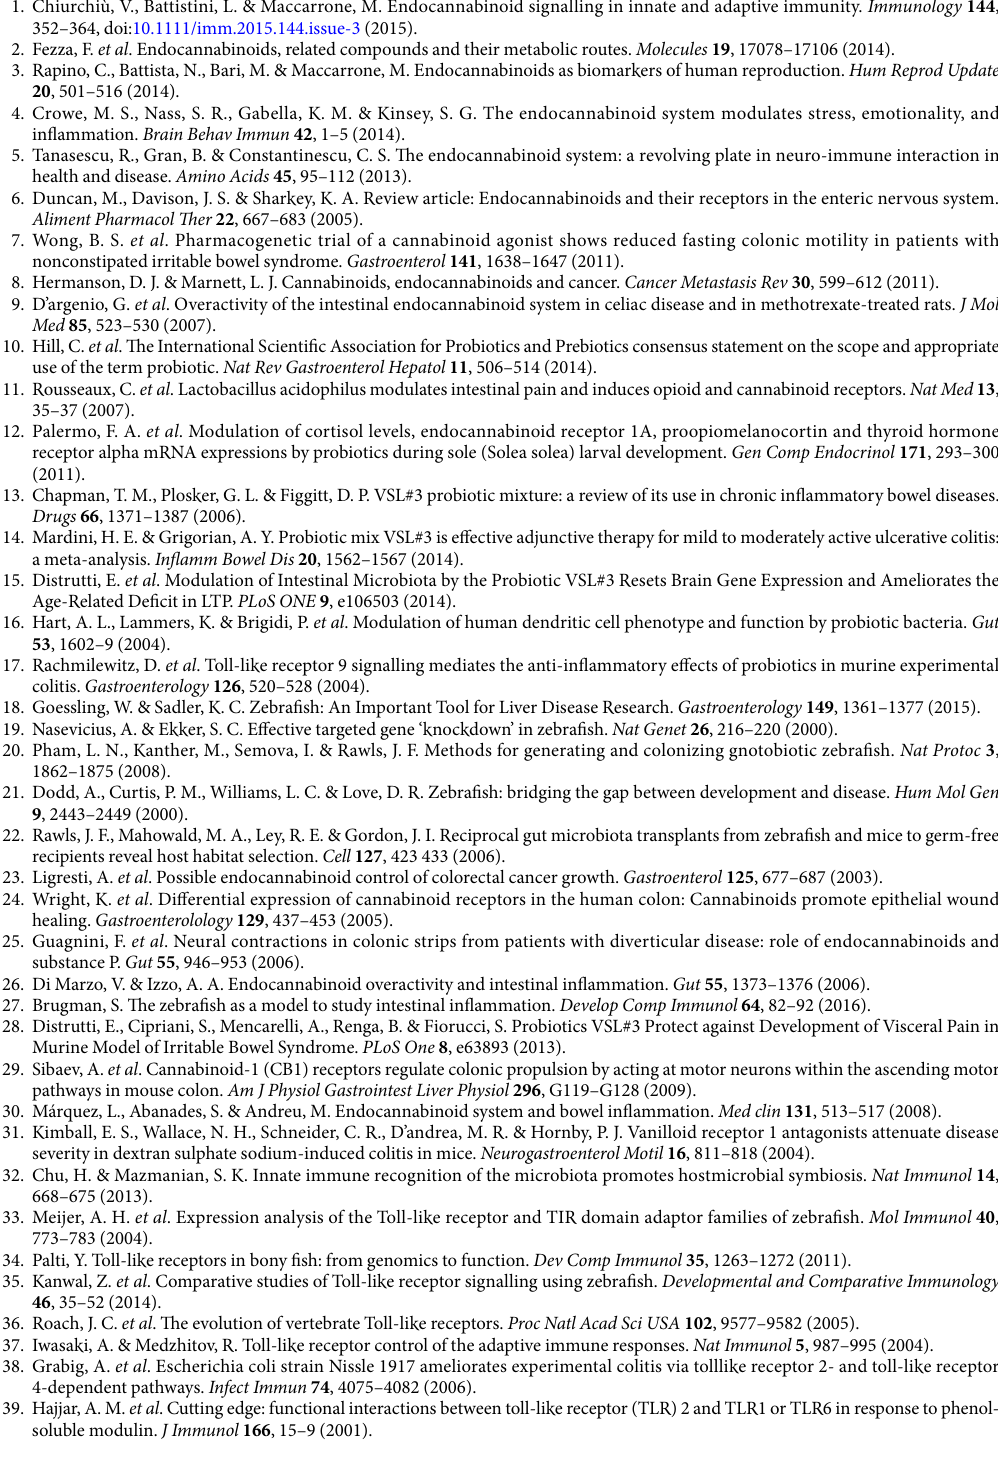
iQ5 optical system software version 2.0 (Bio-Rad) including GeneEx Macro iQ5 Conversion and genex Macro iQ5 files. The primer sequences used are reported in Table 2S. Statistical analysis. Data are presented as mean ± SD. Student’s t-test was used for comparison between the two experimental groups for in vivo experimentation. Two-Way ANOVA followed by the Tukey test as a multiple comparisons test was used for comparison among experimental groups for ex vivo experimentation. Statistical evaluation of enterocyte length, villus height, crypt depth and villus height/crypt depth ratio were tested by vari- ance analysis and confirmed by nonparametric methods (Wilcoxon). All statistical analyses were performed using the statistical software package Prism5 (Graphpad Software, Inc. USA) with significance accepted at P <